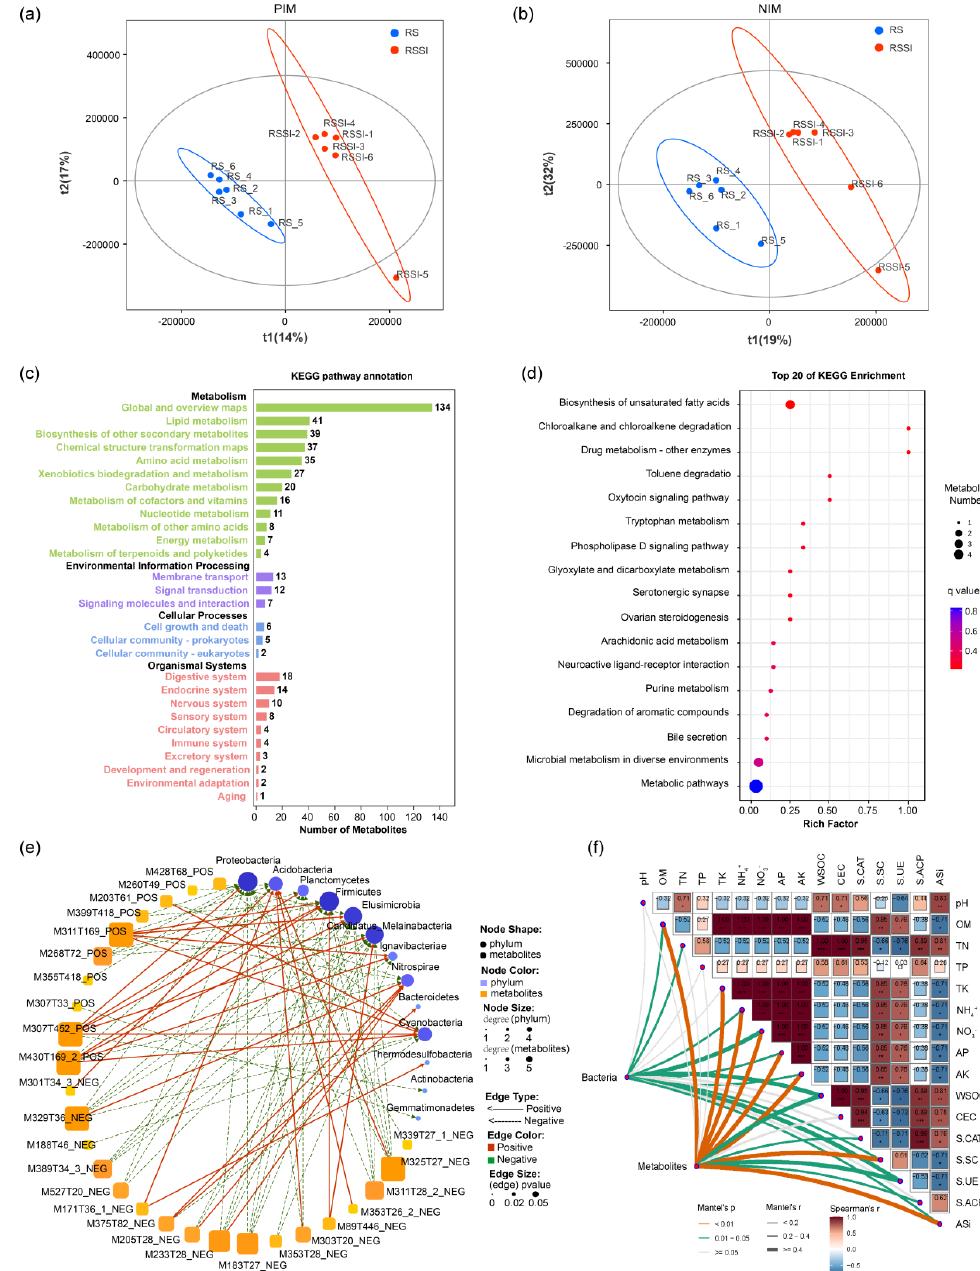
Figure 5. Impact of Si on rhizosphere soil metabolite profiles under R. solanacearum inoculation. ( a , b ) PLS − DA analyses showed the metabolite profiles of POS and NEG patterns in RS_vs_RSSI, respectively. (c) Annotation of the KEGG pathway enrichment analysis of total metabolites in all treatments. ( d ) Bubble map demonstrated the KEGG pathway enrichment analysis of differential metabolites in RS_vs_RSSI. ( e ) Co − occurrence network analysis of the Pearson correlation between differential metabolites of RS_vs_RSSI and the relative abundance of bacterial communities at the phylum level. ( f ) Pairwise comparisons of environmental factors, the bacterial community (genus level), and the differential metabolites with a color gradient indicating Spearman’s correlation coeffi- cients. Rhizosphere soil bacterial and metabolite profiles were correlated with each environmental factor by Mantel tests. Spearman’s correlation coefficients were shown with a color gradient. Edge width and edge color denoted the Mantel’s r statistic and statistical significance levels,